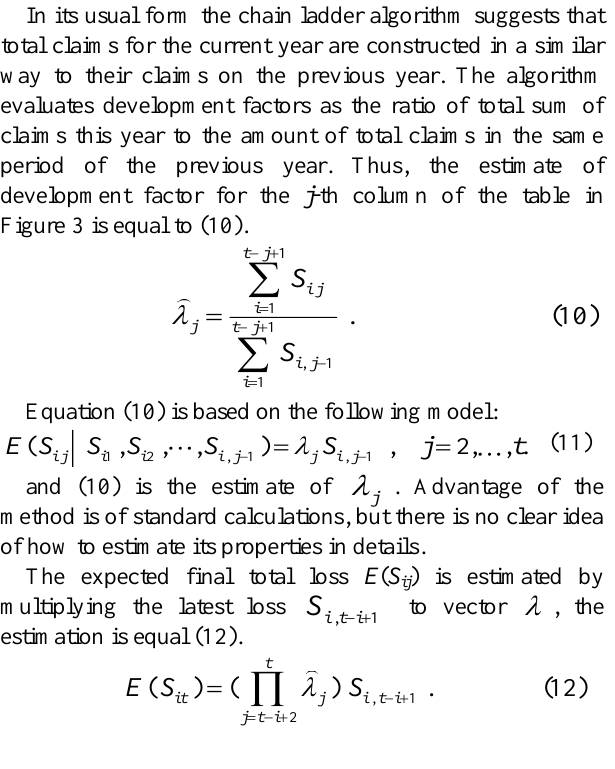
Fig.1. We will determine maximum likelihood estimates